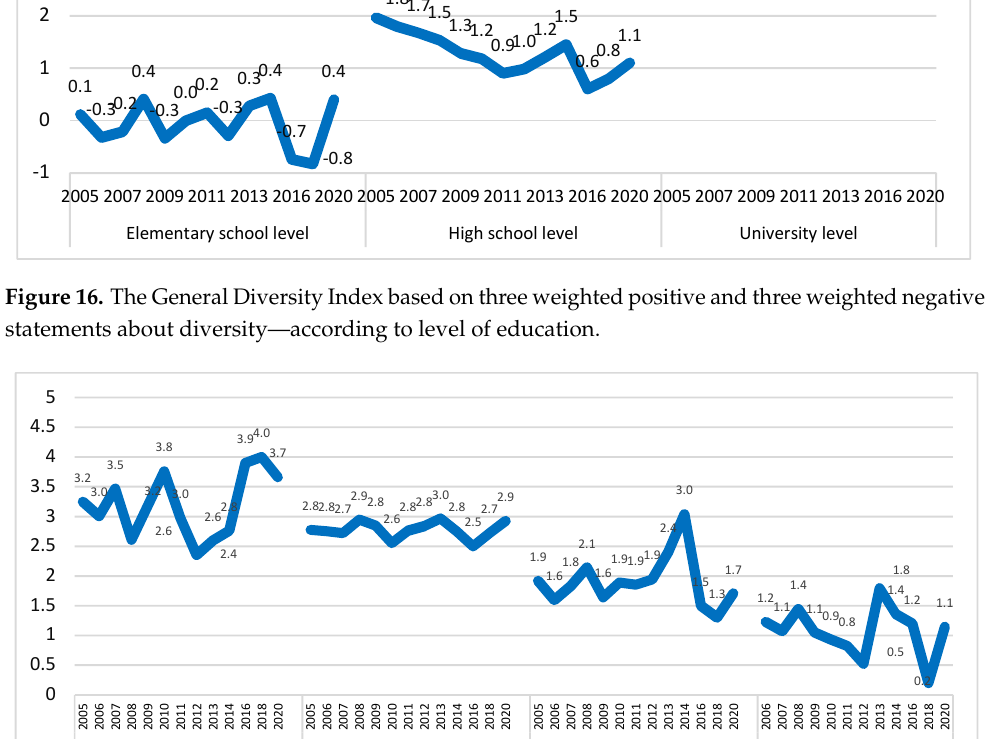
Figure 17. The General Diversity Index based on three weighted positive and three weighted negative statements about diversity—according to age group.